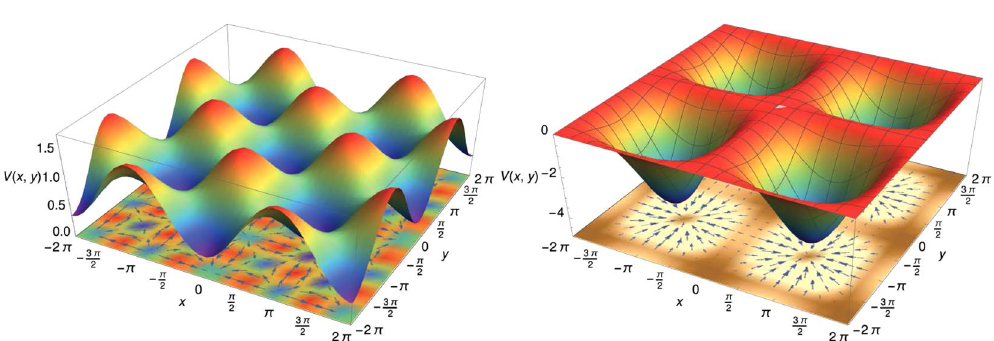
Figure 5. Potential V ( x , y ) for (left) the mixed attractive/repulsive 2 D -HMF model, (right) the fully attractive 2 D -HMF model. The bottom horizontal plots represent the force vector fields ∇ − V